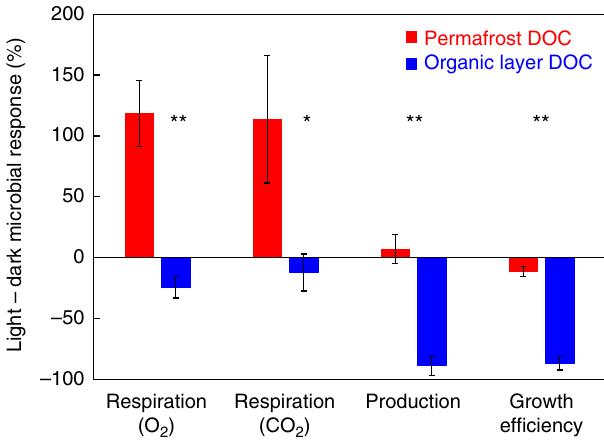
Fig. 2 Microbial activity response to photo-altered dissolved organic carbon. Light-exposed minus dark-control percent change in microbial respiration (O 2 consumption and CO 2 production), microbial production, and microbial growth ef fi ciency for permafrost dissolved organic carbon (DOC, red ) and organic layer DOC ( blue ). Error bars indicate ± 1 standard error of the mean ( N = 3). Signi fi cance levels reported for an unpaired t -test: * = P < 0.05, ** = P <